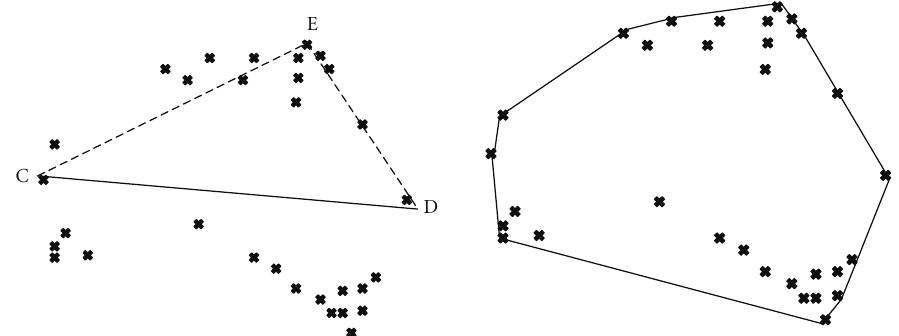
Figure 5: Convex Hull from a set of unorganized